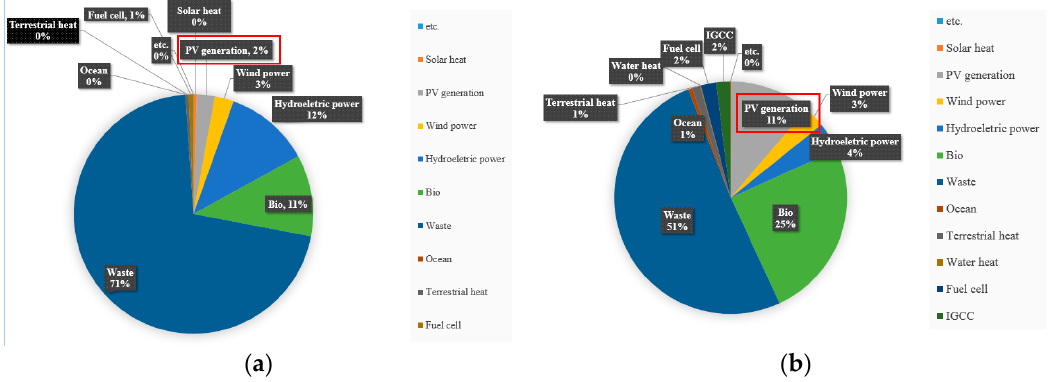
Figure 1. Korea renewable energy supply status in 2010 vs. 2018. ( a ) 2010; ( b ) 2018.